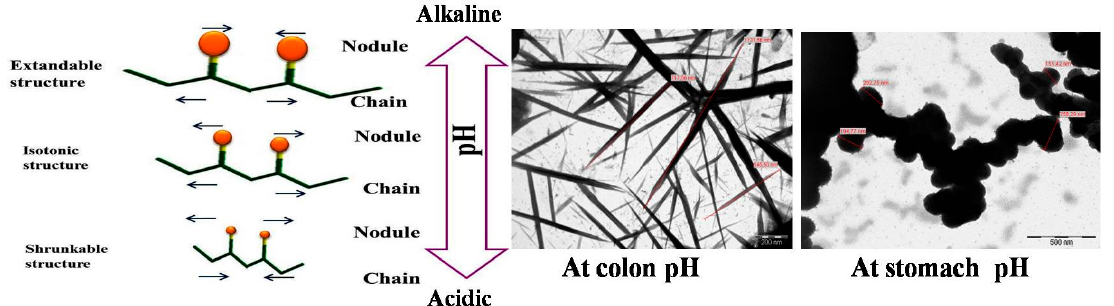
Figure 4. Poly(acrylic acid)extended at alkaline condition and shrunk at acidic condition(figure adapted from [49] and [56]).